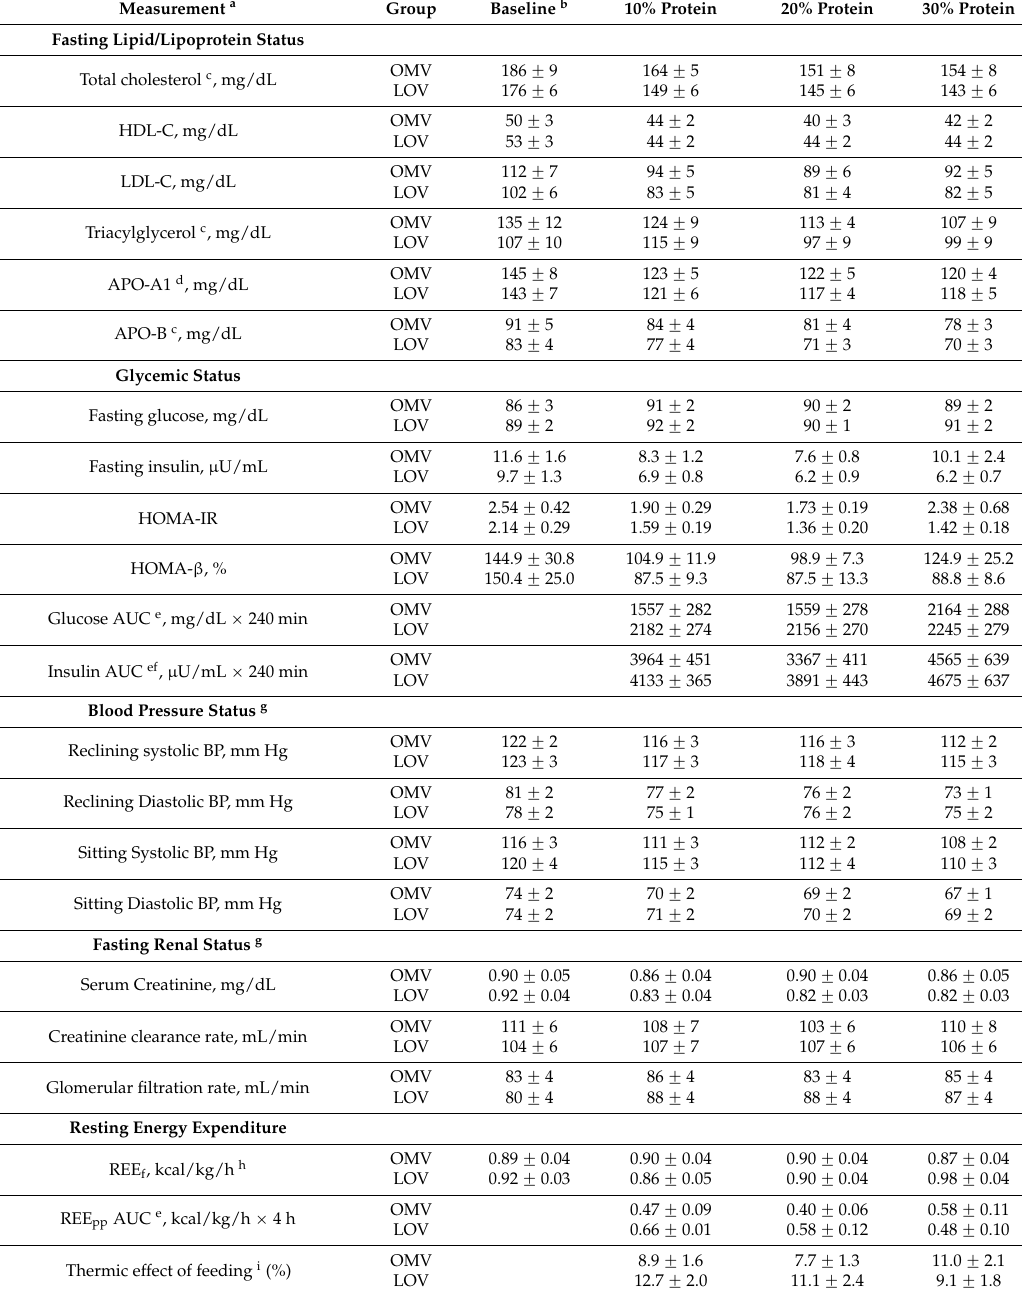
Table 2. Cardio-metabolic and renal responses of the omnivore (OMV) vs. lacto-ovo vegetarian (LOV) groups at baseline and at the end of each protein quantity-specific period Measurement